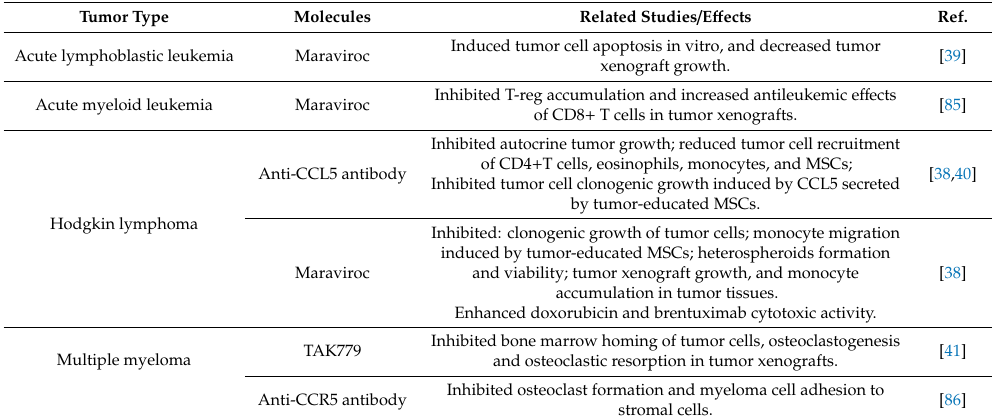
Table 1. E ff ects of CCL5 / CCR5 axis disruption in hematological